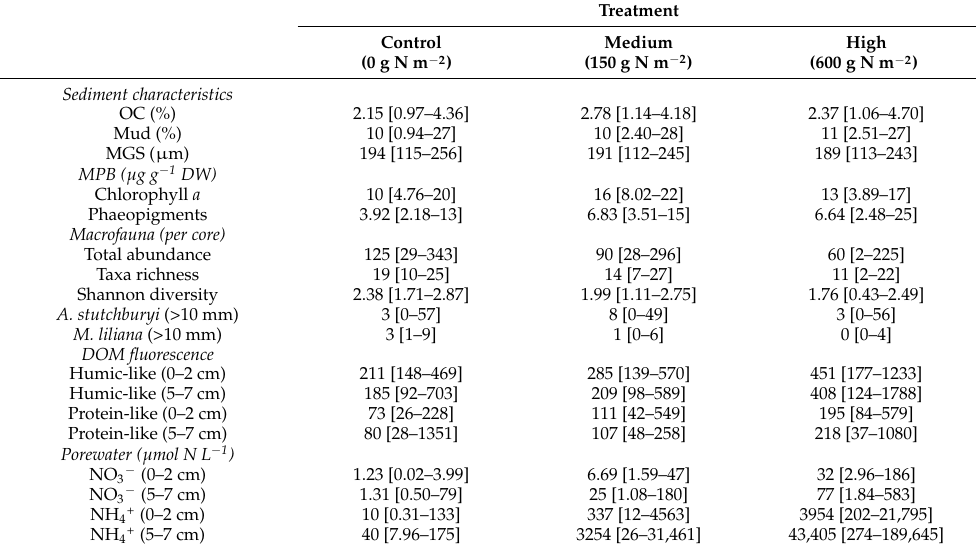
Table 1. Summary of sediment properties and univariate indices of macrofaunal communities as a function of sediment nutrient enrichment treatment. Data presented are the median (the range is in brackets) across winter and summer (n = 27), except for macrofaunal abundance, richness and diversity where only summer data were available (n = 18).